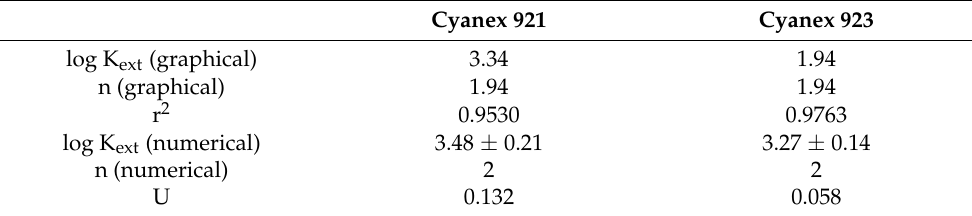
Table 4. Values of log K ext and n for chromium(VI) extraction by Cyanex 921 and Cyanex